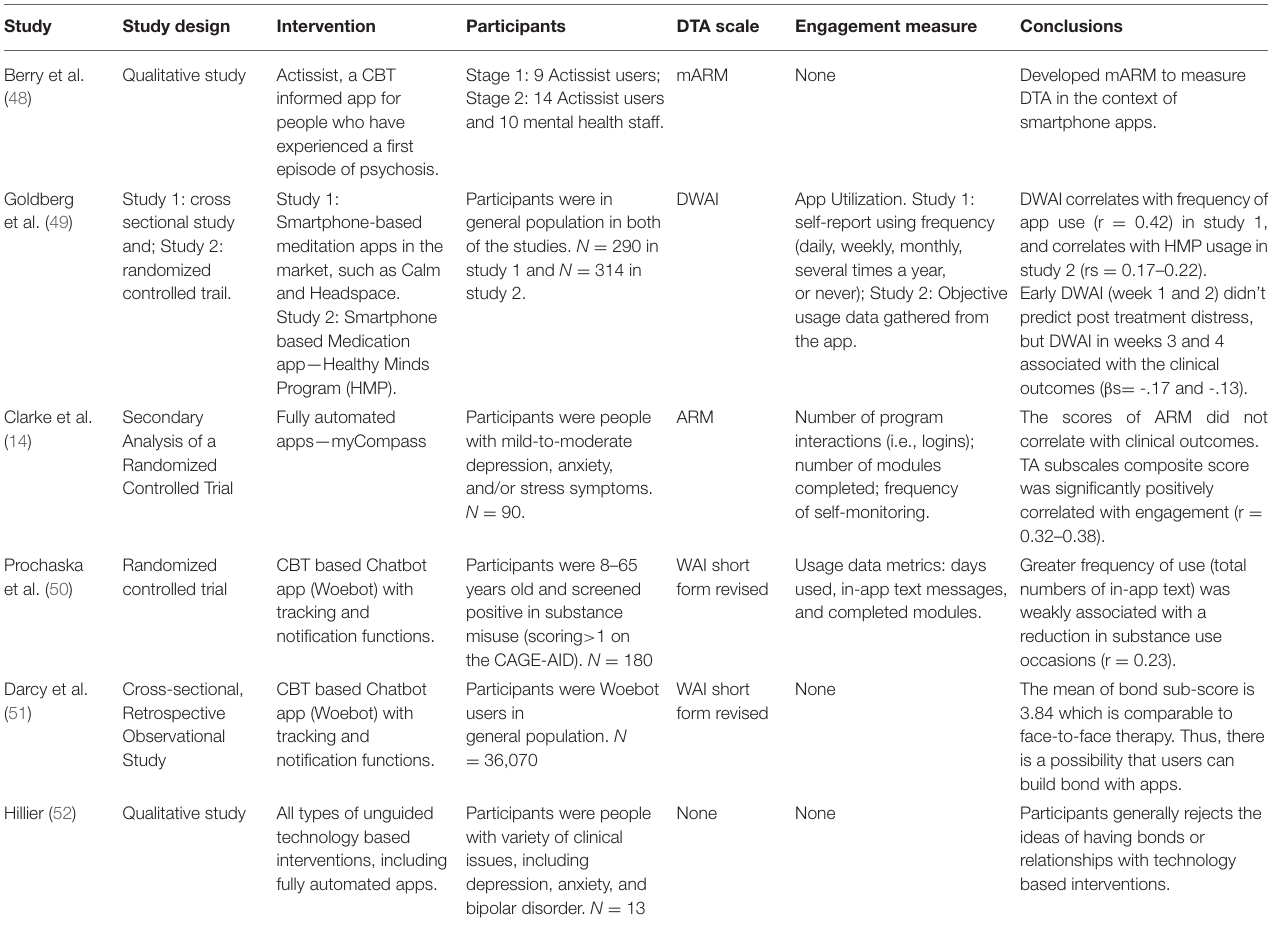
TABLE 2 | Basic study characteristics and